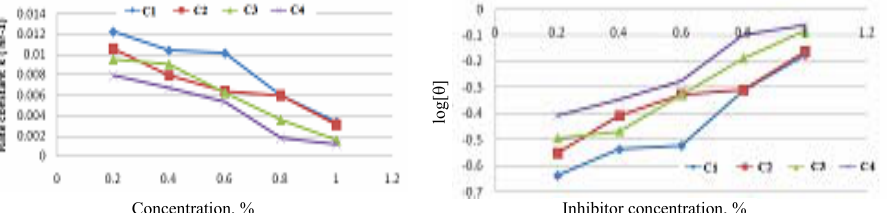
Figure 2. Inhibitor concentration vs log ( θ )